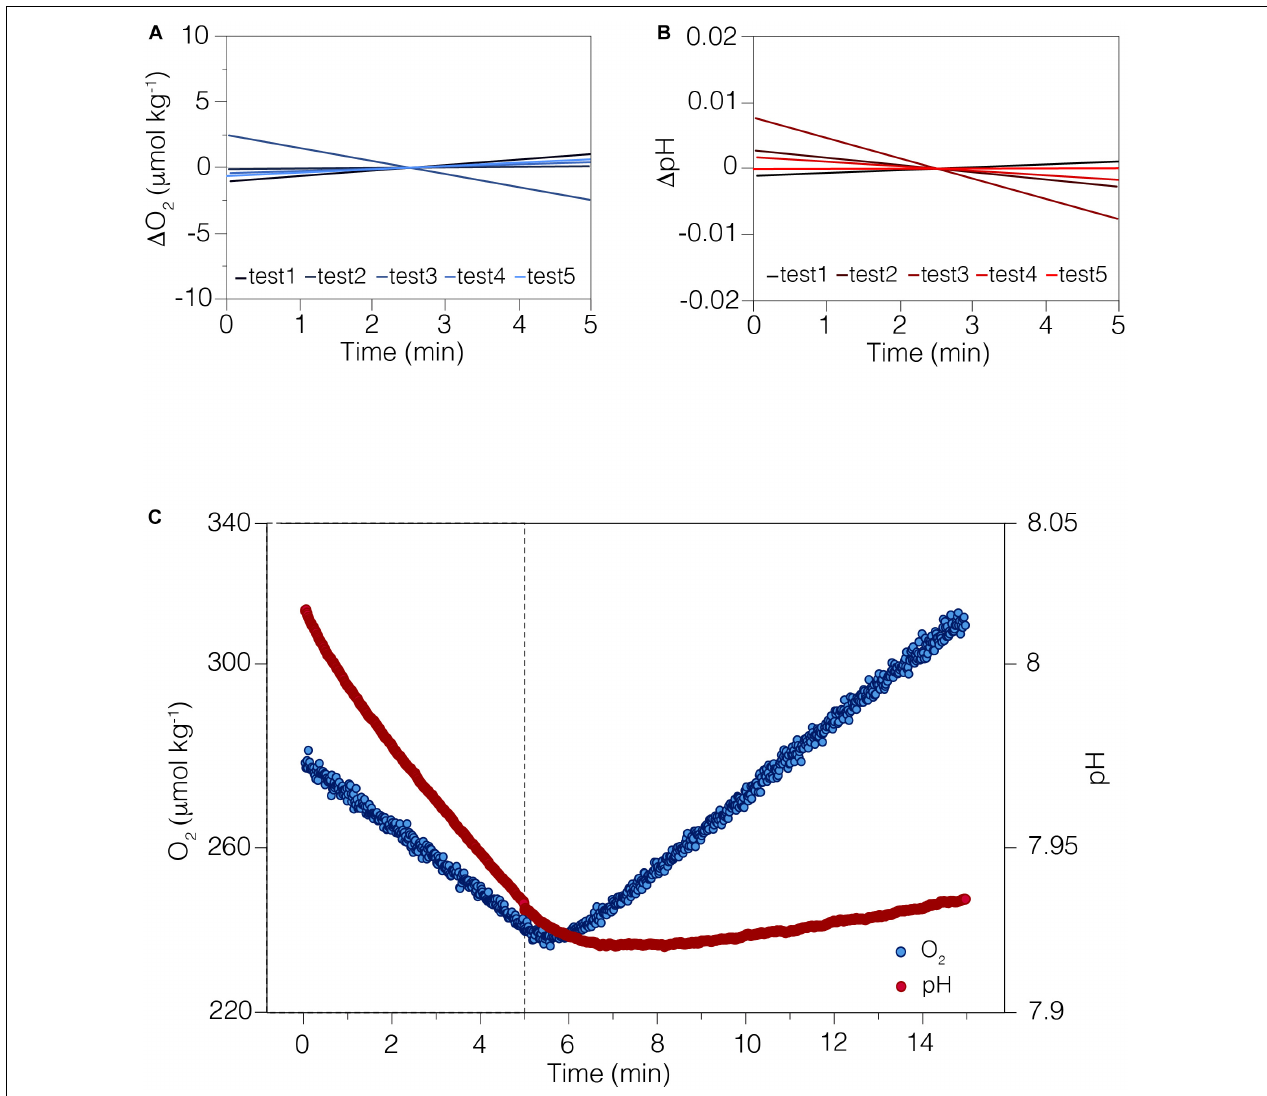
FIGURE 2 | The sensors performance during CISME deployments. (A) The stability of the O 2 sensor measured in filtered seawater over the 5-min in an open container in laboratory-controlled conditions. Trend lines of five independent test show anomalies from the mean. (B) The stability of the pH sensor over the 5-min in an open container in laboratory-controlled conditions. Trend lines of five independent test show anomalies from the mean. The slight trend in both sensors is likely due to small changes in temperature during the test. (C) Real-time O 2 and pH data stream and status of analysis displayed on the tablet during typical 15-min incubation on coral surface, 5-min in the dark followed by 10-min in regulated light conditions. The analytical precision, defined as one standard deviation over time, for O 2 was ± 2.33 mmol kg - 1 and ± 0.02